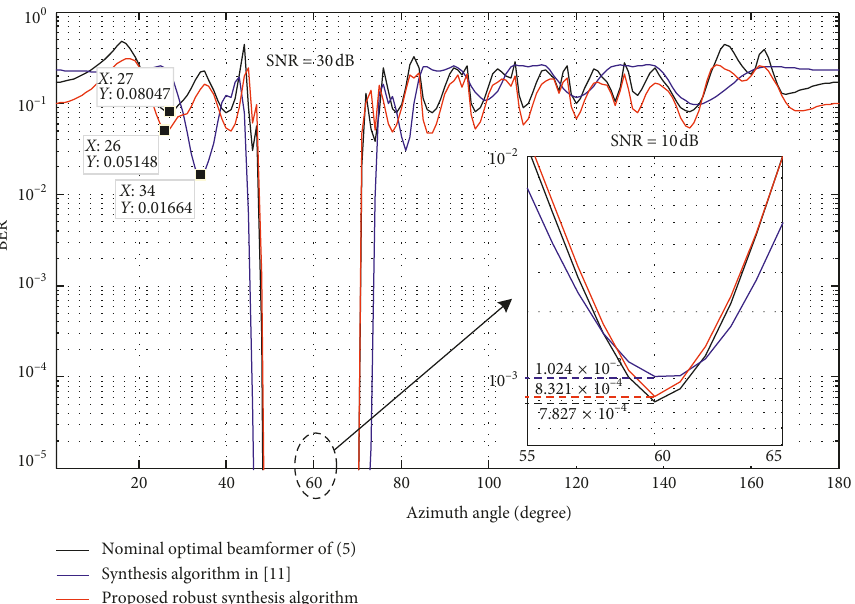
Figure 6: BER performances of different synthesis algorithms for the DM